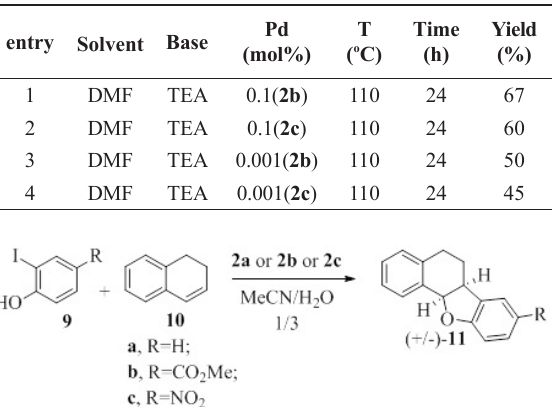
Yields and main conditions for the reaction shown in Figure 5.